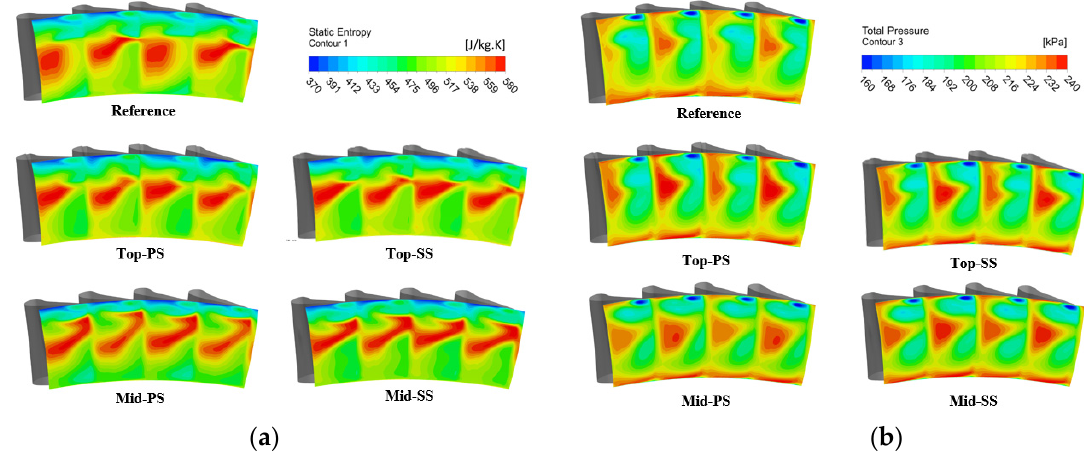
Figure 8. ( a ) Static entropy; ( b ) Total pressure at the R 1 outlet under various blade conditions.